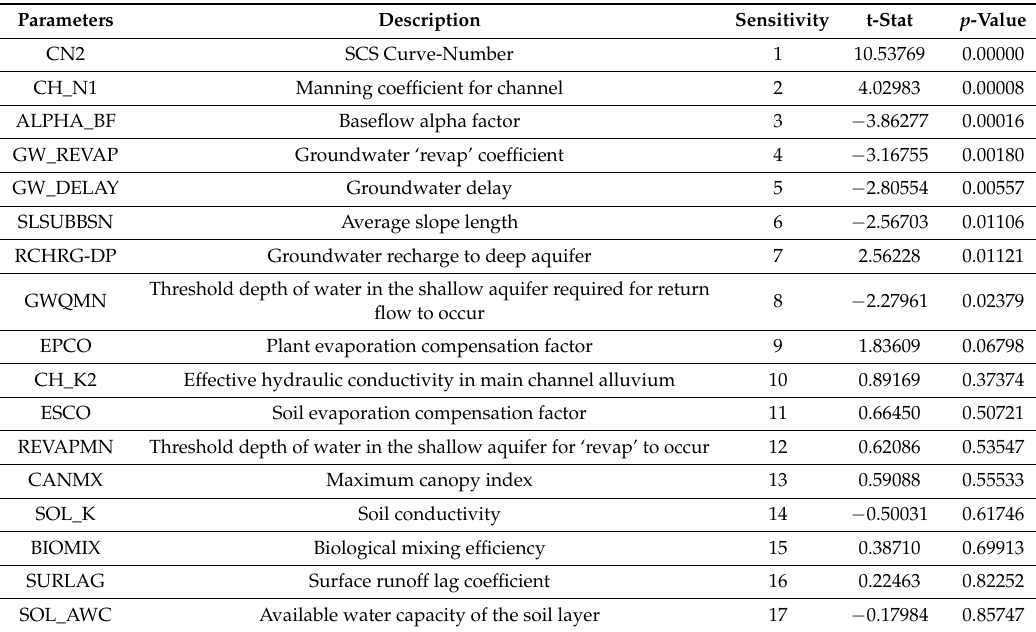
Table 3. Parameters used in the sensitivity